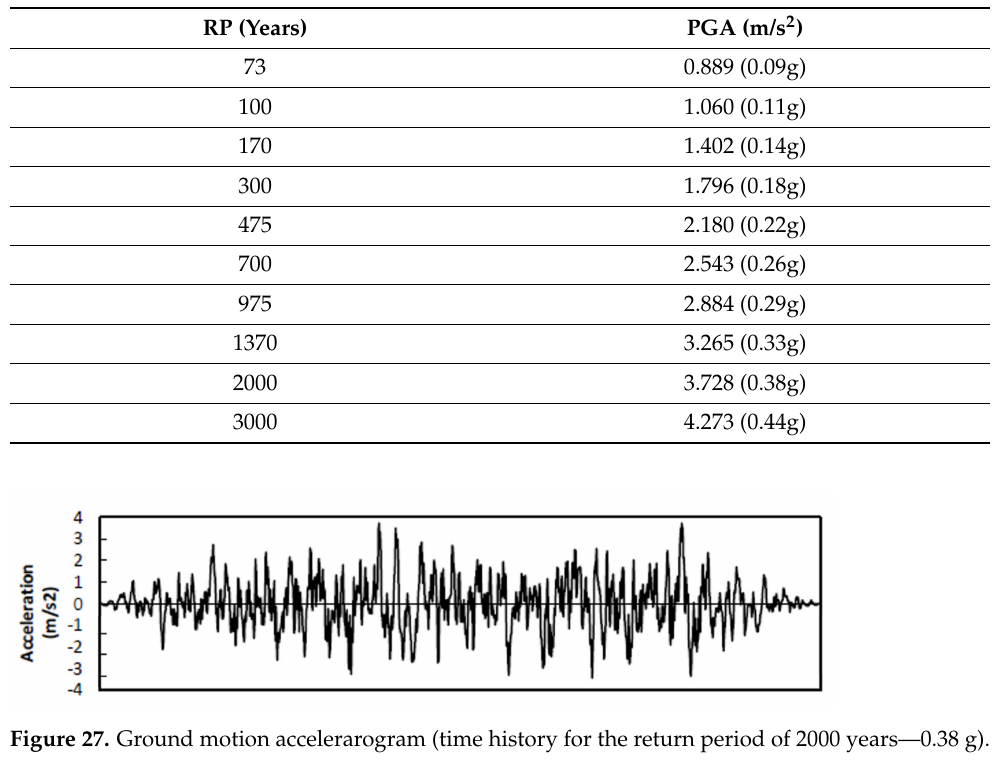
Table 2. Peak ground acceleration and corresponding return period (RP).